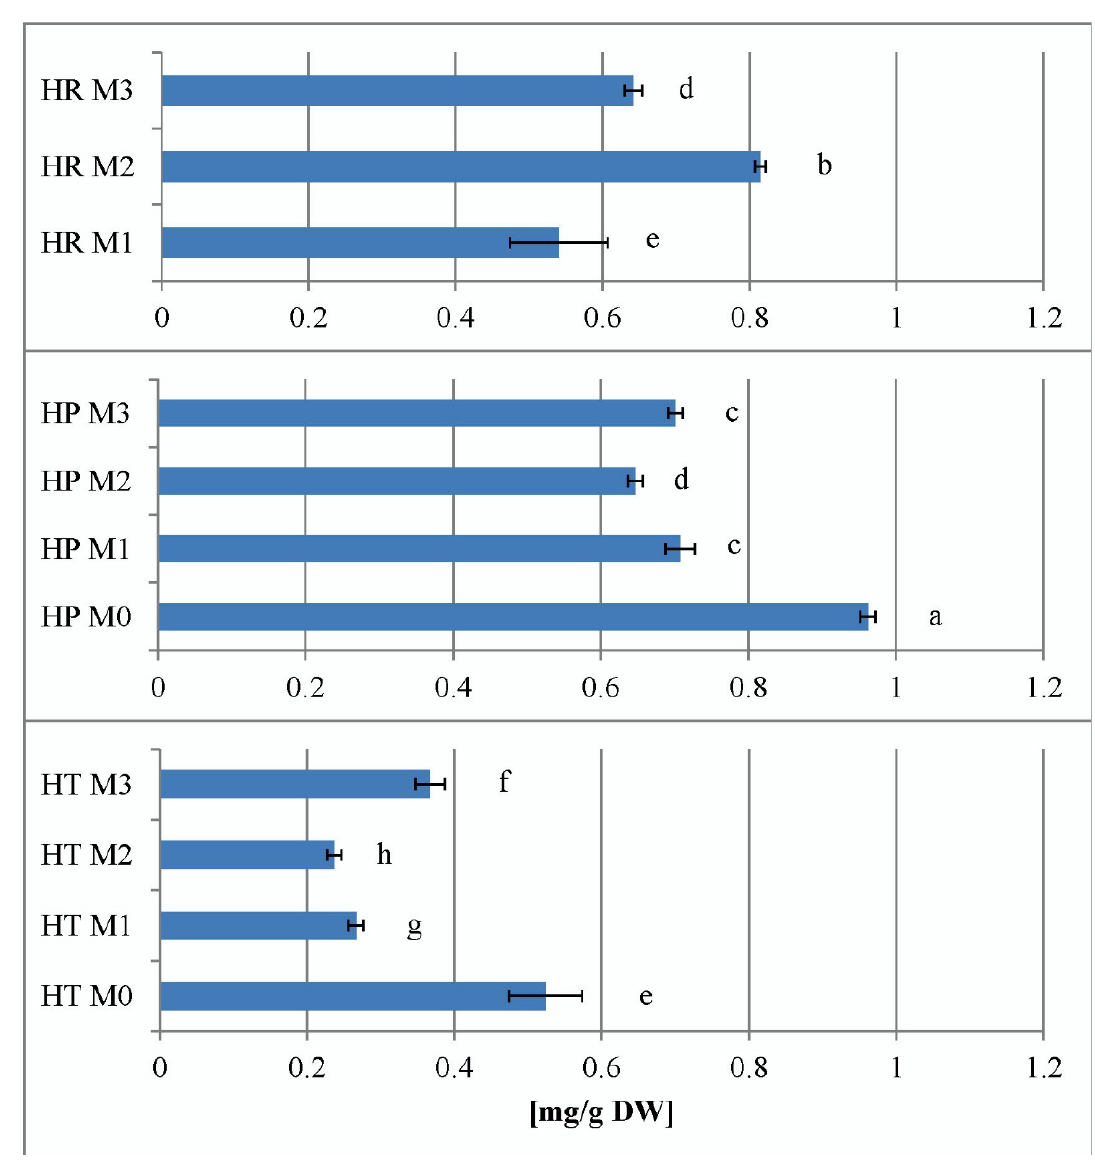
Figure 5. Total hypericin content in the three Hypericum ssp. in M_0—PGR-free, M_1—0.2 mg/L BA, M_2—0.2 mg/L BA + 0.1 mg/L IBA and M_3—0.1 mg/L BA + 0.2 mg/L IBA supplemented media. HP— H. perforatum L., HR— H. richeri Vill. and HT— H. tetrapterum Fries. All measurements were performed in triplicate and the values are given as mean ± SD. Same letters denote non-significant differences and different letters denote statistically significant differences of the means.